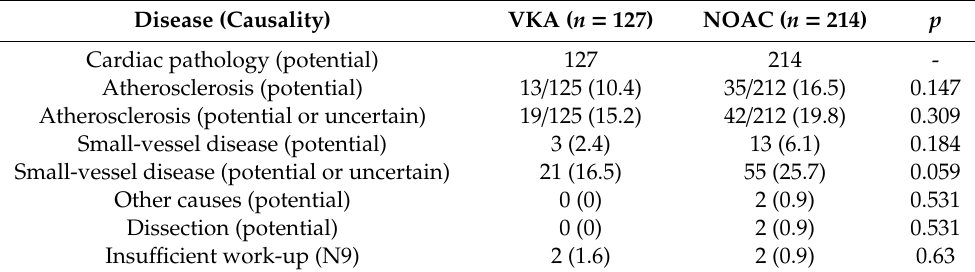
Table 2. Etiologic classification.